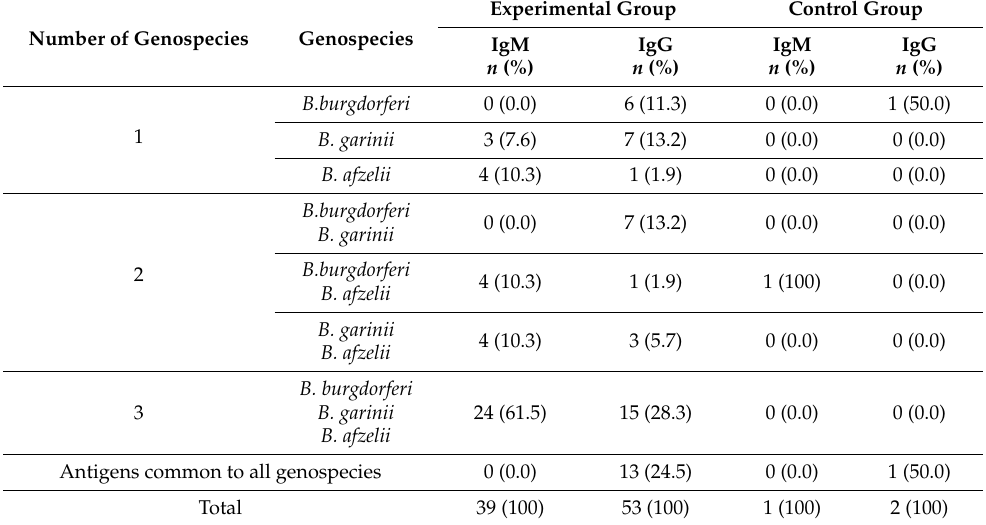
Table 3. IgM and IgG seroreactivities to Borrelia g enospecies in Lyme disease patients (experimental group) and in healthy individuals (control